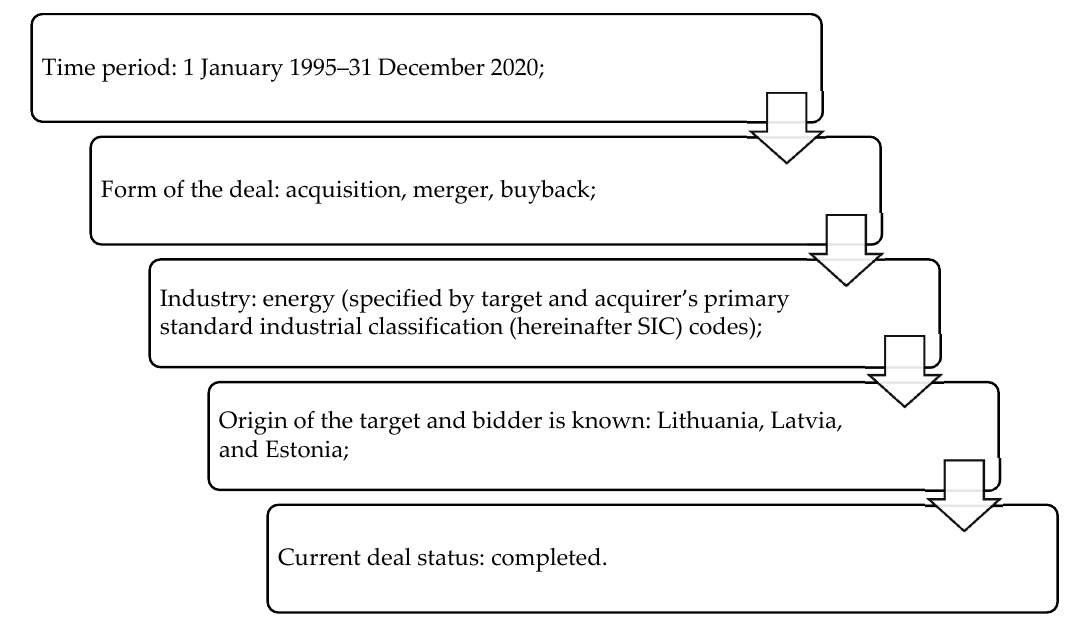
Figure 5. Selection criteria of M&A data sample used in the research. Source: authors.